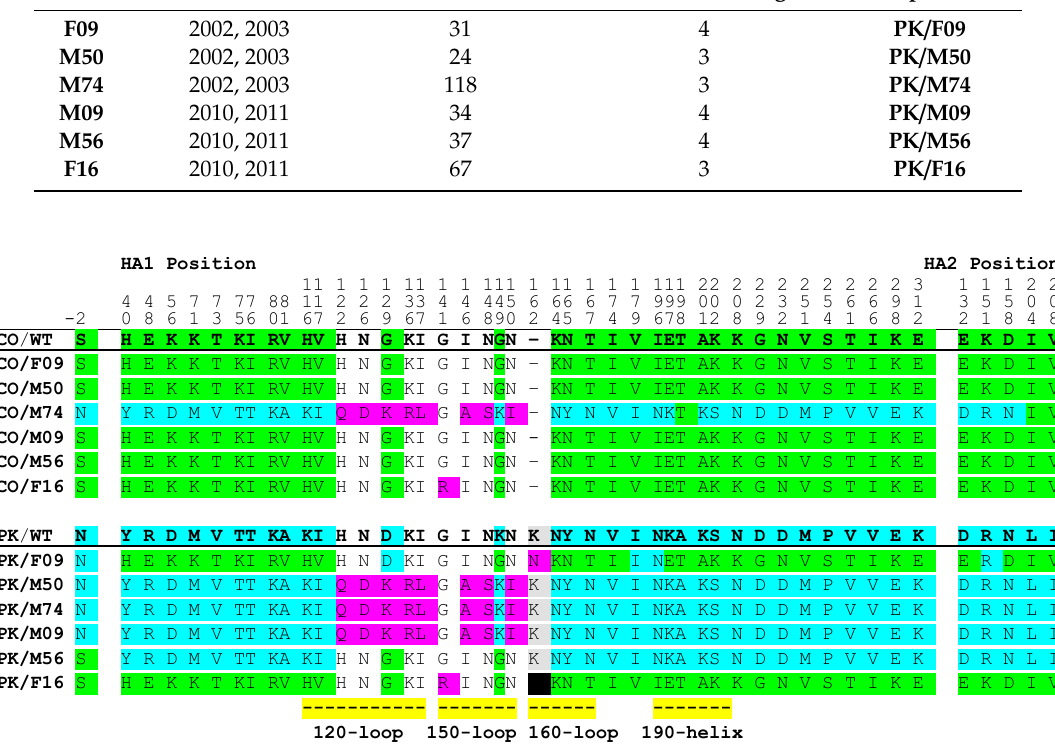
Figure 1. HA consensus ( > 50%) sequences of wild-type and escape viruses. Viruses are labeled as in Table 1. NGS sequence data for each escape virus was translated and aligned with the sequence from the input virus. The wild-type virus sequence is underlined an in bold font. Numbering is based on the Yamagata lineage B / Phuket / 3073 / 2013 (PK / WT) sequence. Amino acid sequences common to the PK / WT sequence that di ff er from the B / Colorado / 06 / 2017 (CO / WT) sequence are highlighted in blue, those common to CO / WT are highlighted in green; mutations resulting in an amino acid not present at levels greater than 50% in the wild-type viruses are shown in pink; and deletions gained through virus passage are highlighted in black. Amino acids associated with known antigenic regions are indicated by yellow bars.